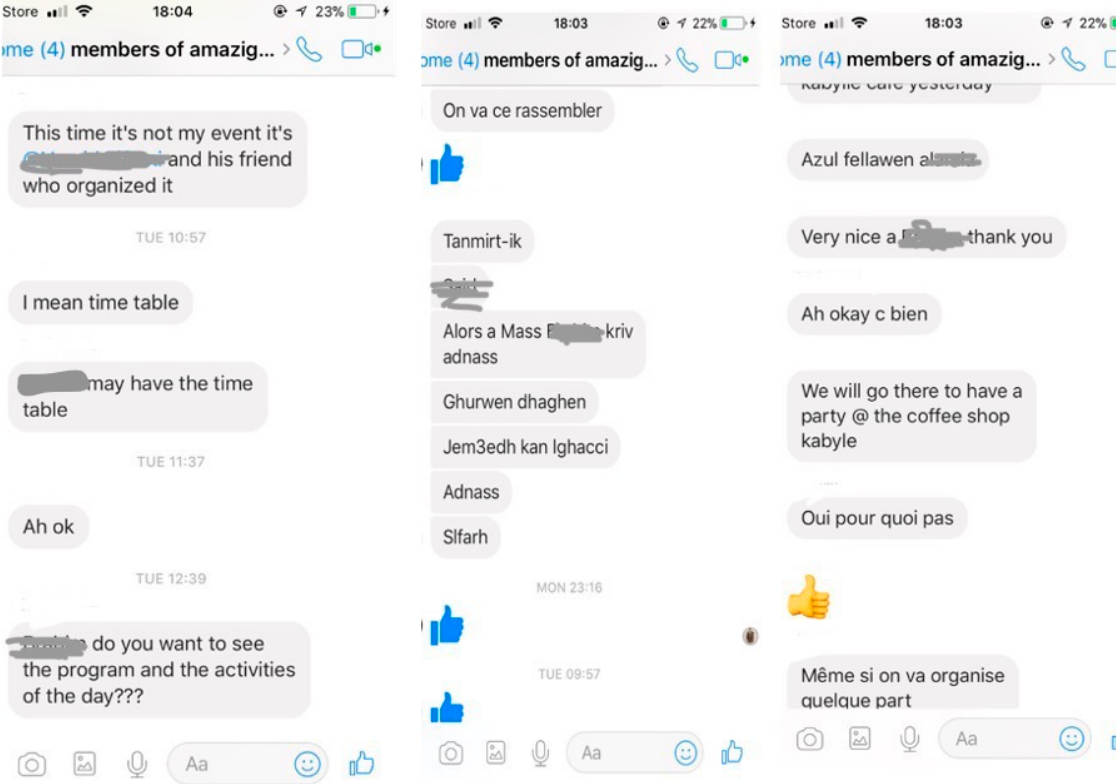
Figure 3. Multilingual conversation between members of the Kabyle/Amazigh Cultural Organization.